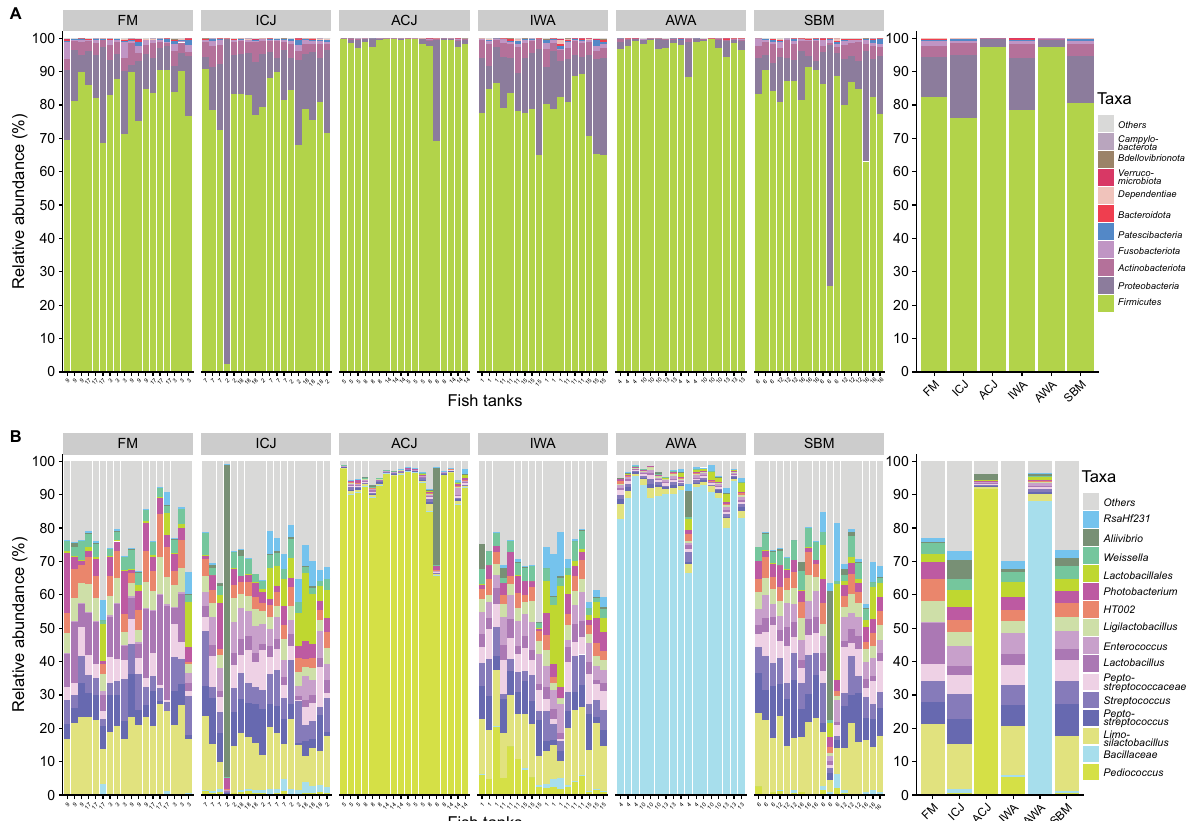
Fig. 2 Microbiota composition in the digesta of fish fed the experimental diets. Relative abundance of the top 10 most abundant taxa at phylum level ( A ) and top 15 most abundant taxa at genus or lowest taxonomic rank ( B ). The mean relative abundance of each taxon within the same diet is displayed on the right side. The samples are grouped by diets; FM—fishmeal-based; SBM—soybean meal-based; 4 experimental diets containing 300 g/kg SBM and 100 g/kg of ICJ—inactivated Cyberlindnera jadinii ; ACJ—autolyzed C. jadinii ; IWA—inactivated Wickerhamomyces anomalus